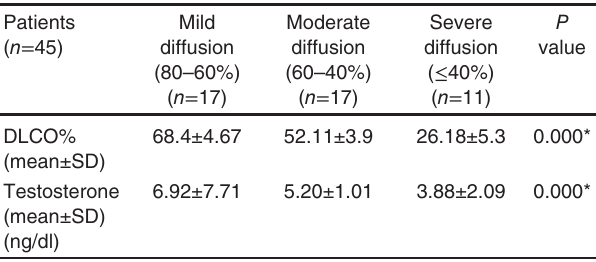
Table 4 Prevalence of erectile dysfunction and serum testosterone levels regarding disease severity ( n = 45) Patients ( n = 45)